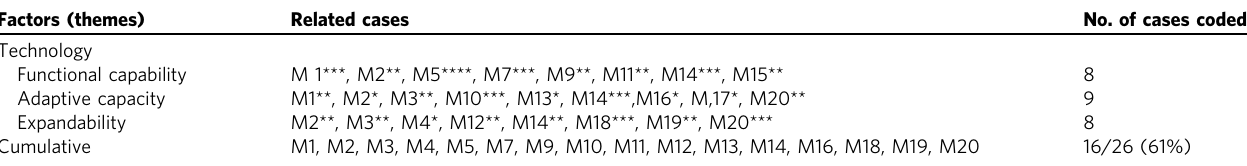
Table 5 Technology factors and supported cases.